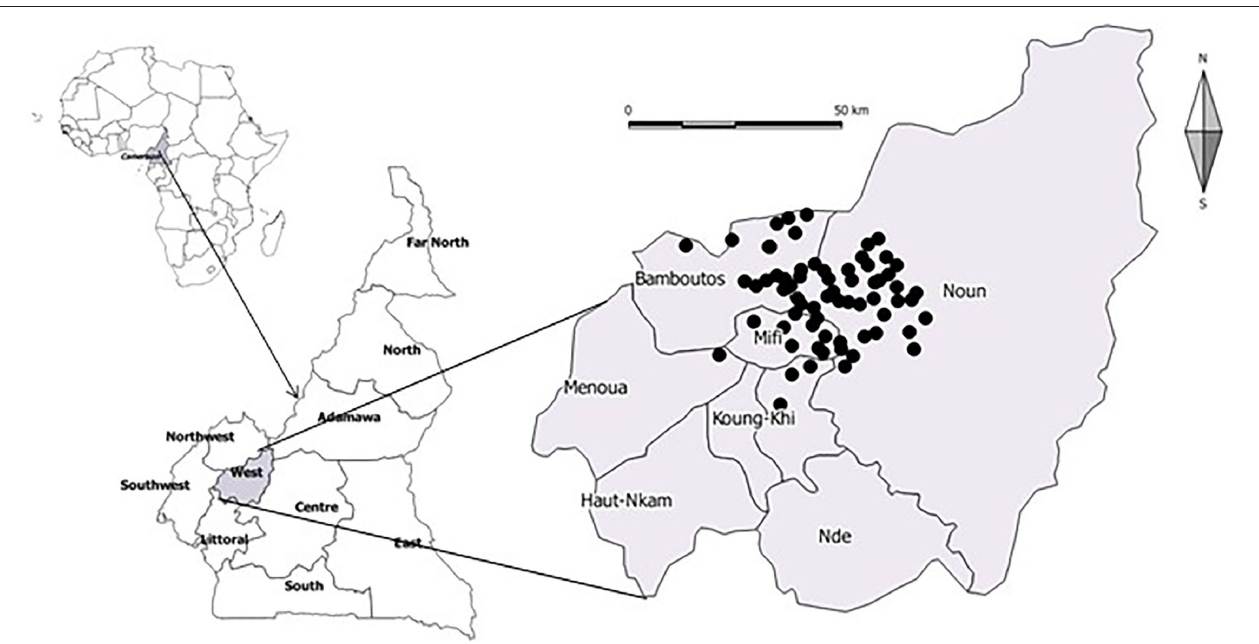
FIGURE 1 | Map showing study areas in the West Region of